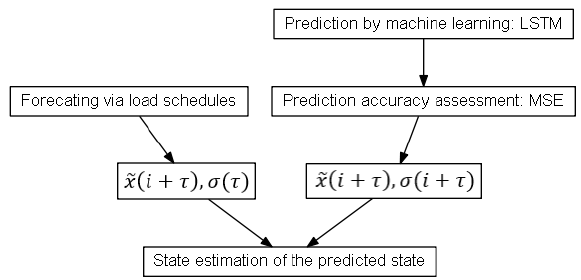
Fig. 5. Combined classical and machine learning prediction algorithm .